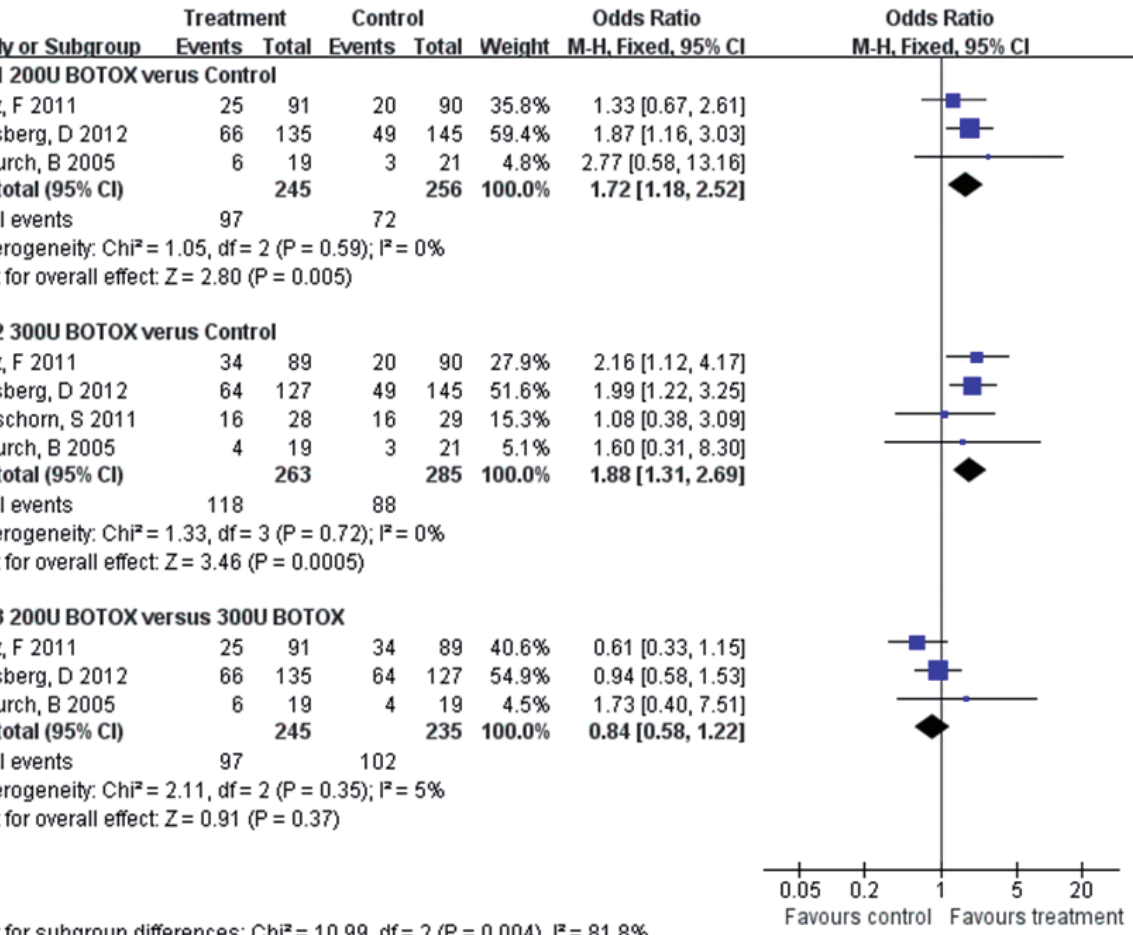
Figure 2 - Forest plot for the outcome of the rate of urinary tract infection